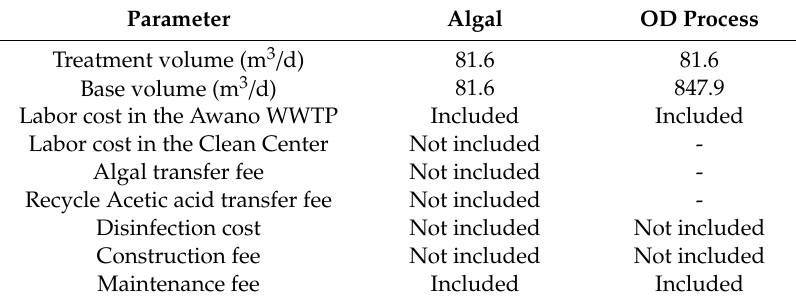
Table 3. Cost calculation parameters for each